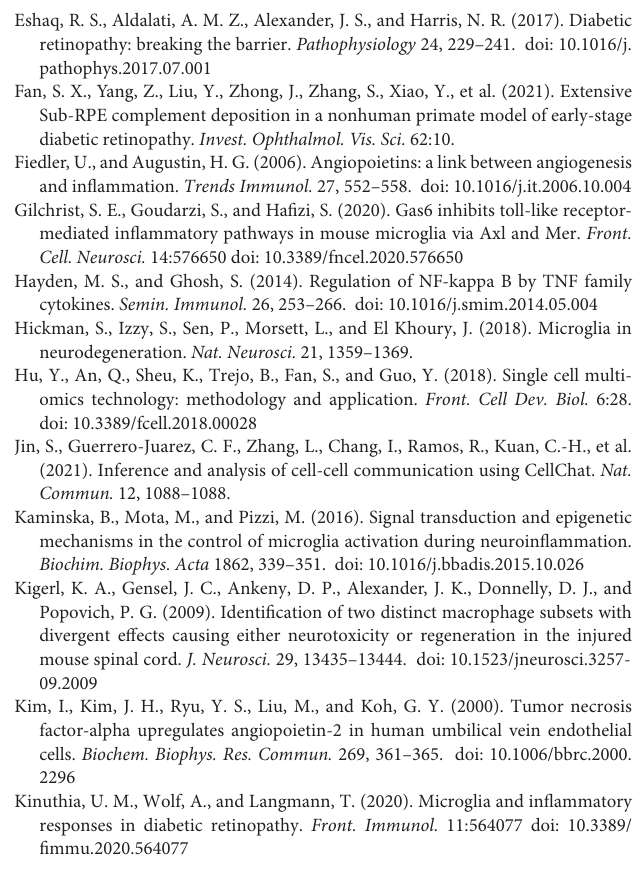
Supplementary Figure 1 | Identification cell types with single-cell transcriptomic profiling. (A,B) UMAP plot showing the single-cell distribution in groups (A) and clusters (B) . (C) Dot plot showing the expression of known marker genes across different cell types. (D) Heatmaps showing the top-ranked 50 (ranked by the average difference among different cell types) marker genes of each cell type. (E) Representative GO terms for each cell type marker genes. Supplementary Figure 2 | Comparison of outgoing and incoming signals in retina of DM and control monkey. All outgoing signaling (A) or incoming signaling (B) for each cell type in two groups. DM: Diabetes mellitus; CTRL: Control. Supplementary Figure 3 | Activation of NF- κ B targets genes which were upregulated in the retina of DM monkey. (A) Venn diagram showing the number of NF- κ B target genes and up-regulated genes by hyperglycemia in the Rod. (B) Dot plot showing the expression of the NF- κ B target genes, which are up-regulated by hyperglycemia in Rod. (C) Dot plot showing the expression of the NF- κ B signals in the retinal cells of DM